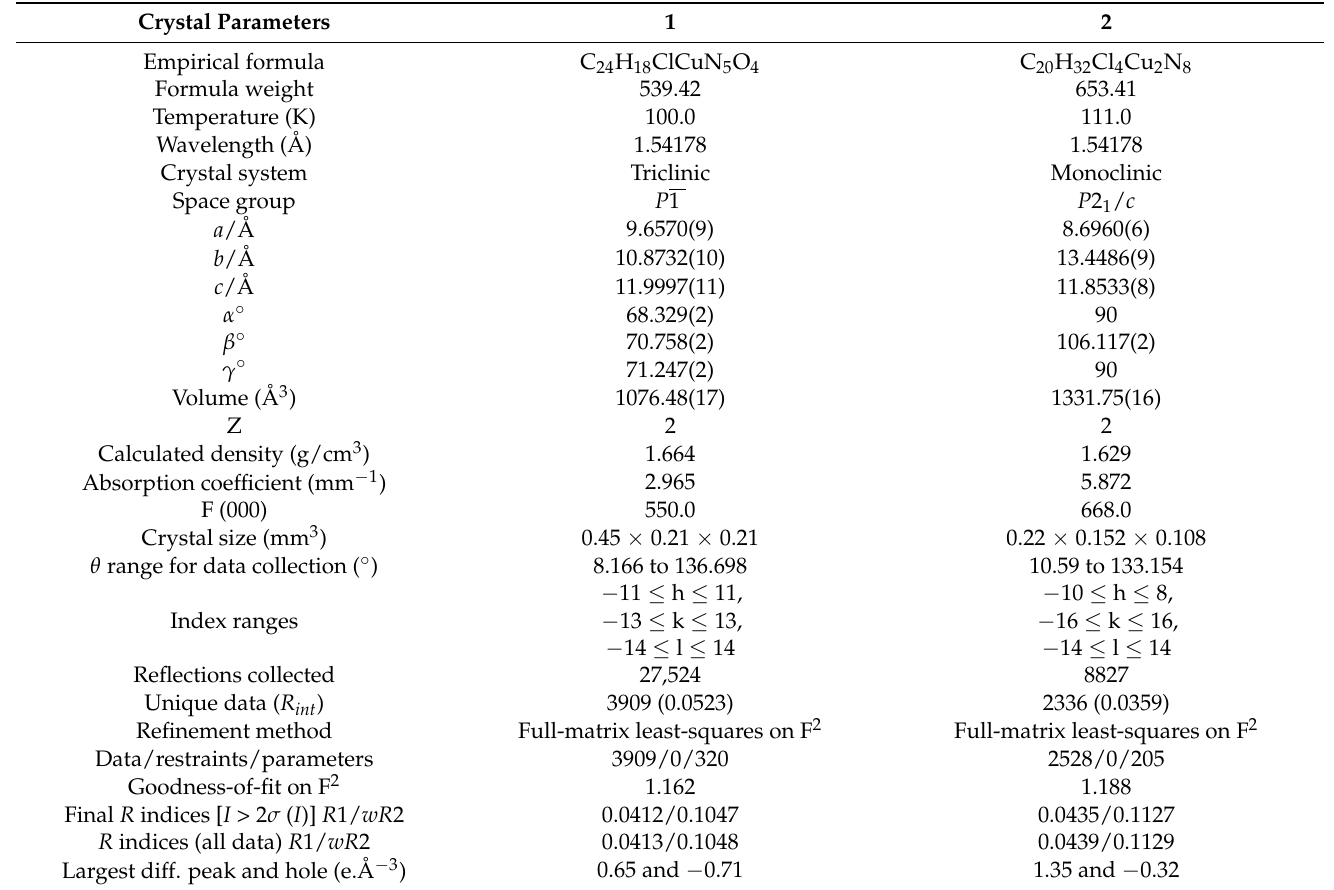
Table 1. Crystallographic data and structure refinement details for compounds 1 and 2